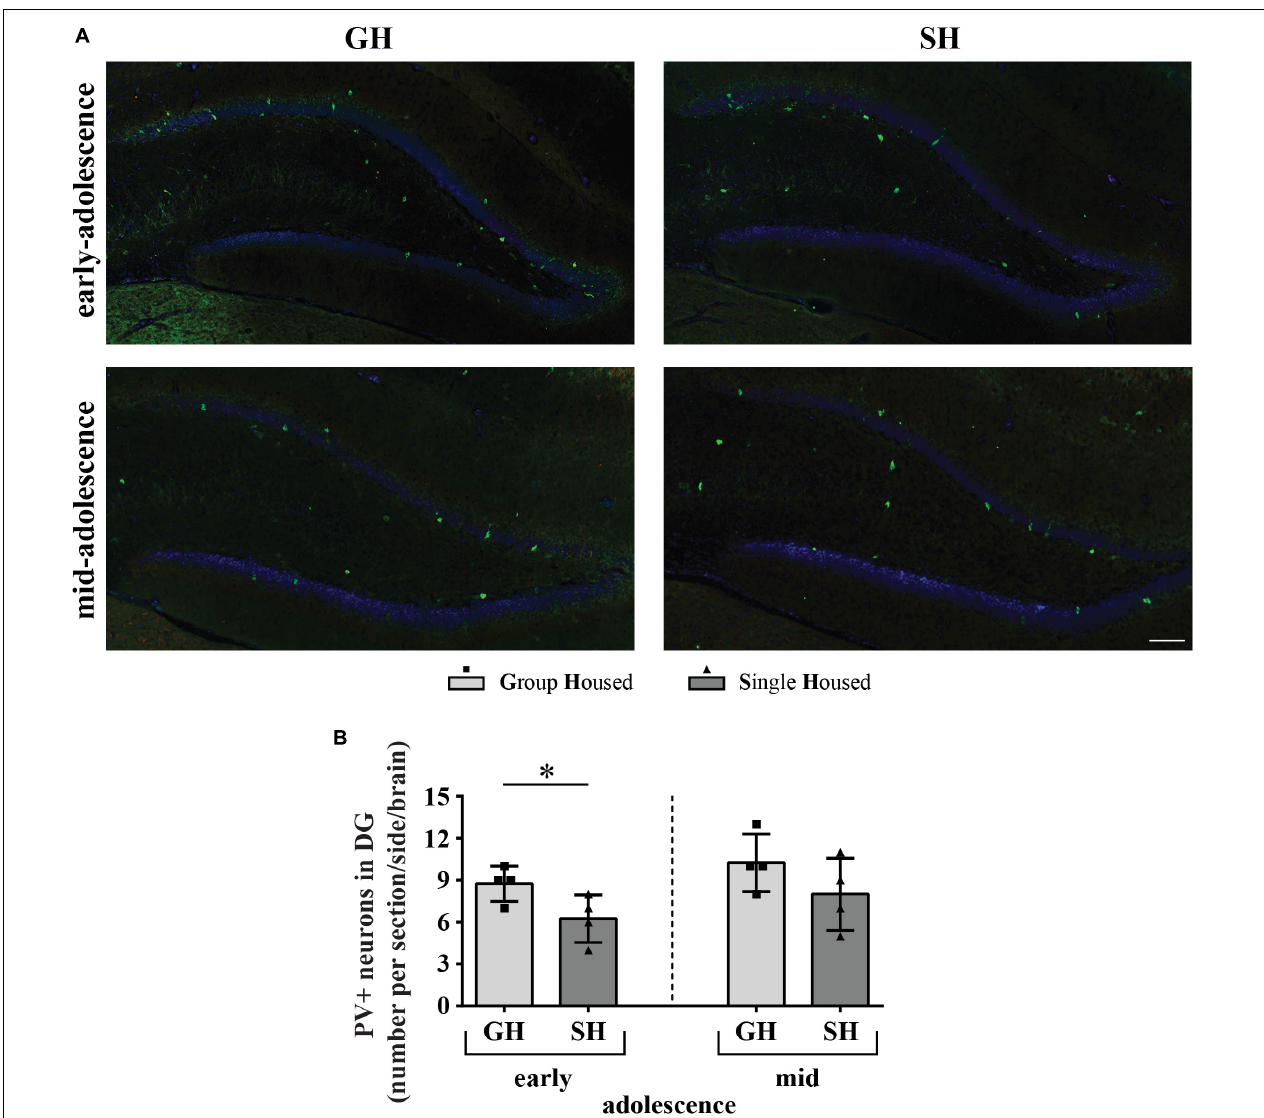
FIGURE 10 | The number of neurons with parvalbumin (PV) immunoreactivity (PVI) in the dentate gyrus of peripubertal rats at the end of the first week (early-adolescence) and the second week (mid-adolescence) of defined housing, which began on the 29th postnatal day. (A) Representative panoramic images for the DG. (B) The number of PVI-labeled neurons in the DG subfield. The dorsal hippocampus was analyzed regarding the adult rat atlas brain (–2.9 to –3.6 mm from the bregma, Paxinos and Watson, 2005). Scale bar 100 µ m. ∗ p ≤ 0.05 (single housed vs. group housed within the same maturational period). Statistical comparisons and exact p -values are given as Supplementary Table S1